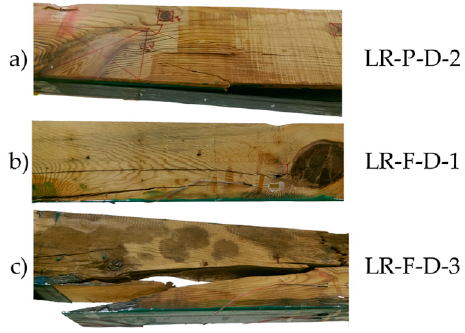
Figure 12. Breakage images of the LR beams group: ( a ) LR-P-D-2; ( b ) LR-F-D-1; and ( c ) LR-F-D-3. CFRP supplier: DRIZORO ® .